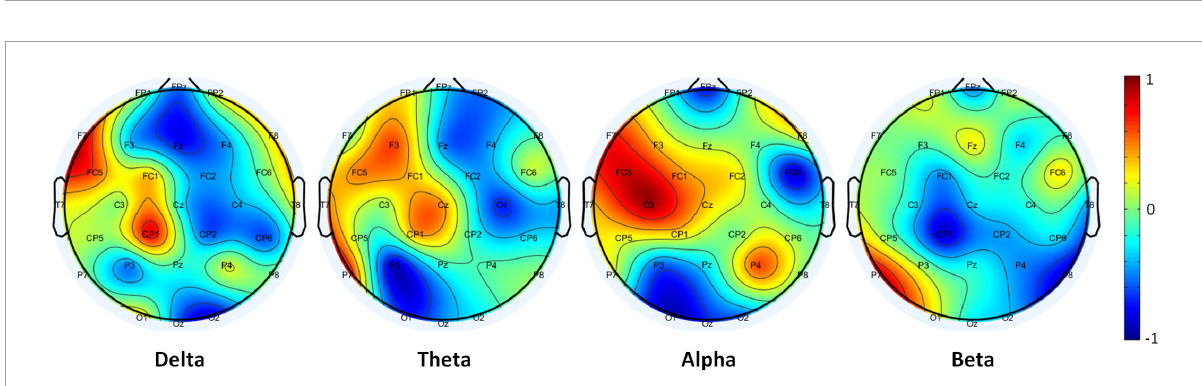
FIGURE6 Differences between average relative band powers of electroencephalography (EEG) features (bands and locations) in two